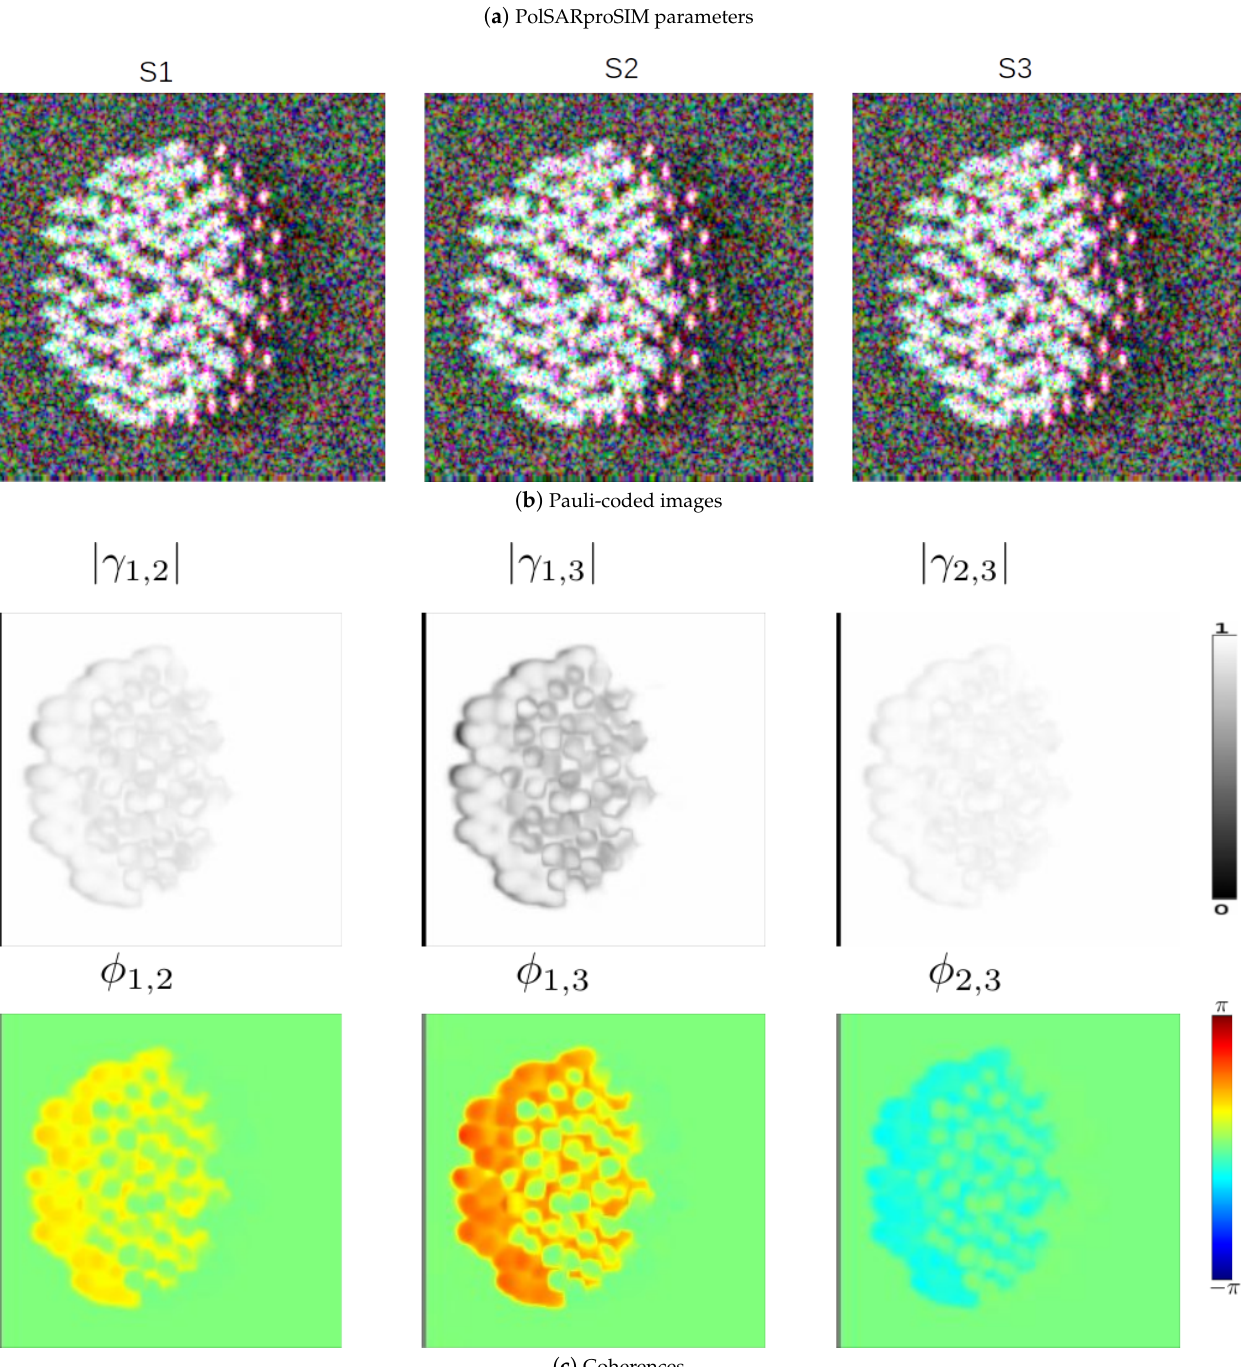
Figure 10. Simulated dual-baseline FP data of forests. The illustrated Pauli-coded images are generated in the case of Roughness =